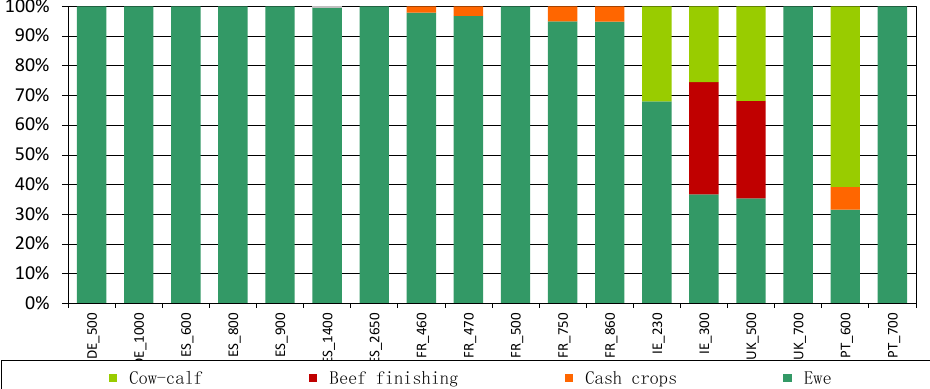
Figure 2. Return structure (% of different farm activities on the farm returns). Source: model results.